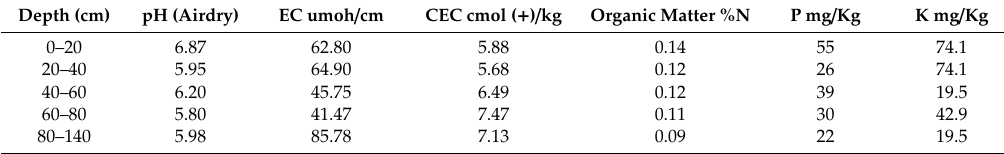
Table 2. Chemical properties of the soil in the experimental field at